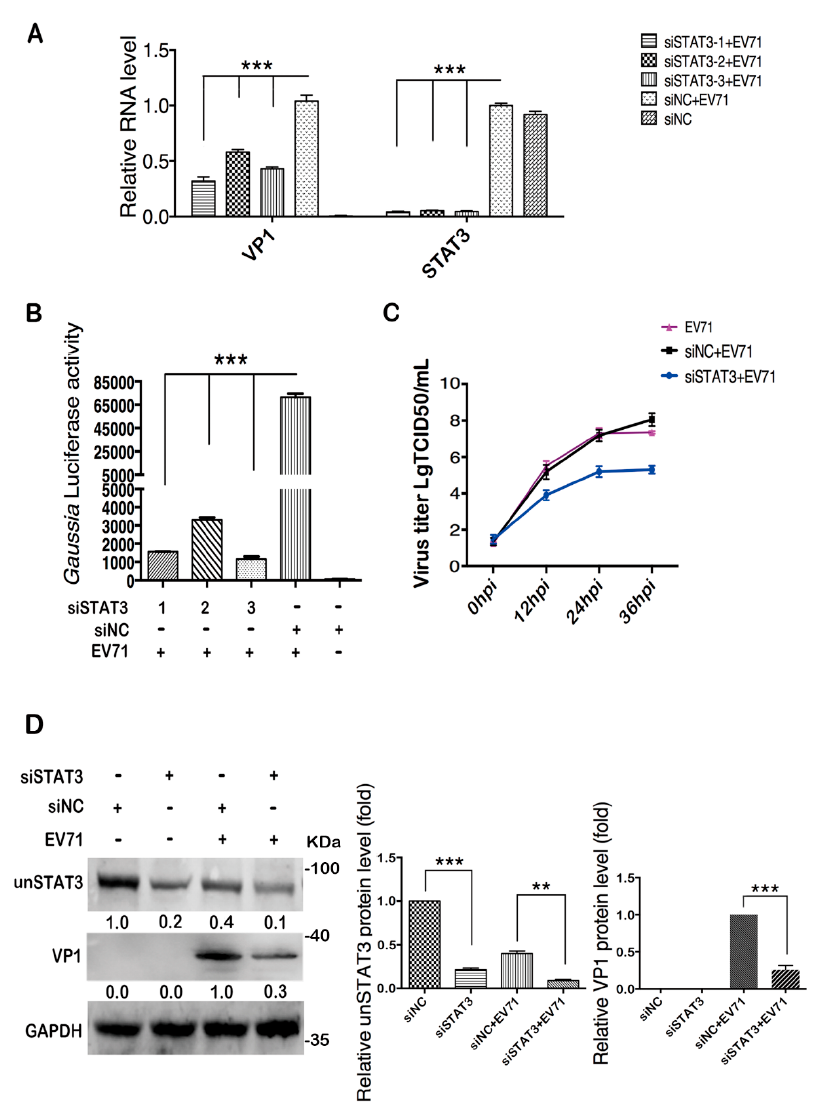
Figure 3. Knockdown of cellular STAT3 restricted EV71 replication. ( A ) STAT3 knockdown restricted viral RNA